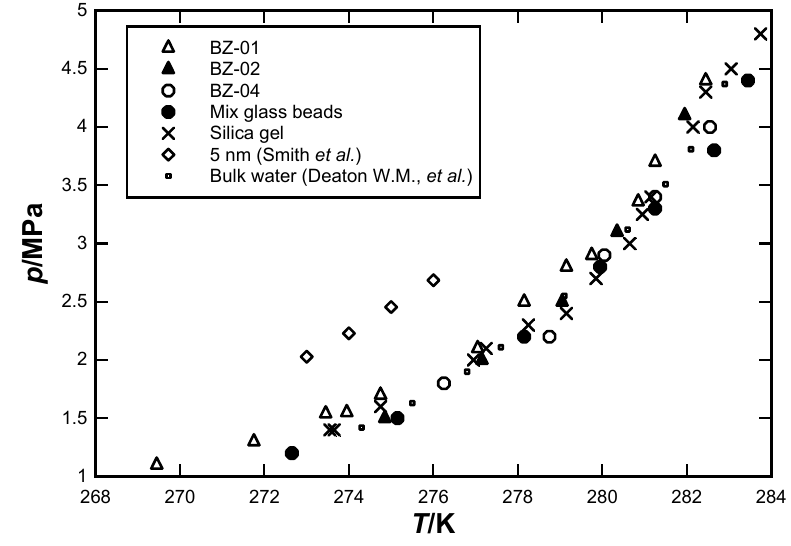
Figure 8. Measurement of equilibrium condition for CO porous